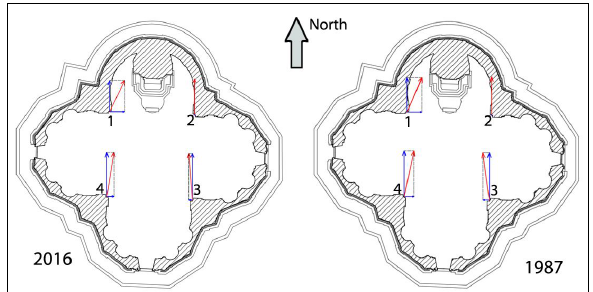
Figure 7. 1987-2016 comparison of the pillars off plumb